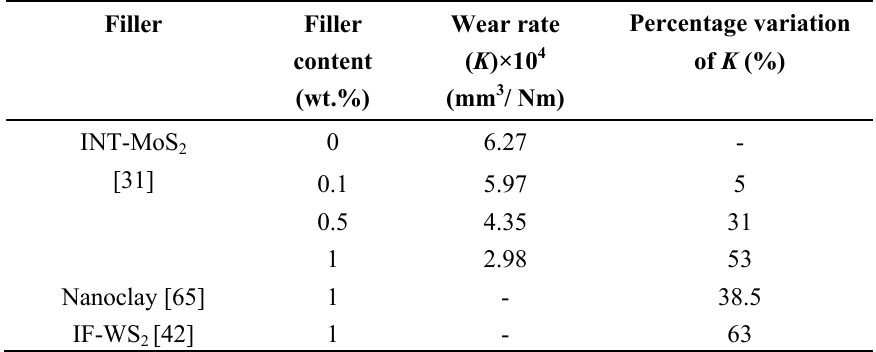
fillers with different